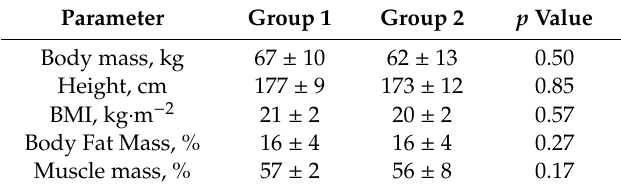
Table 2. Anthropometric characteristics and body composition in Group 1 and 2.